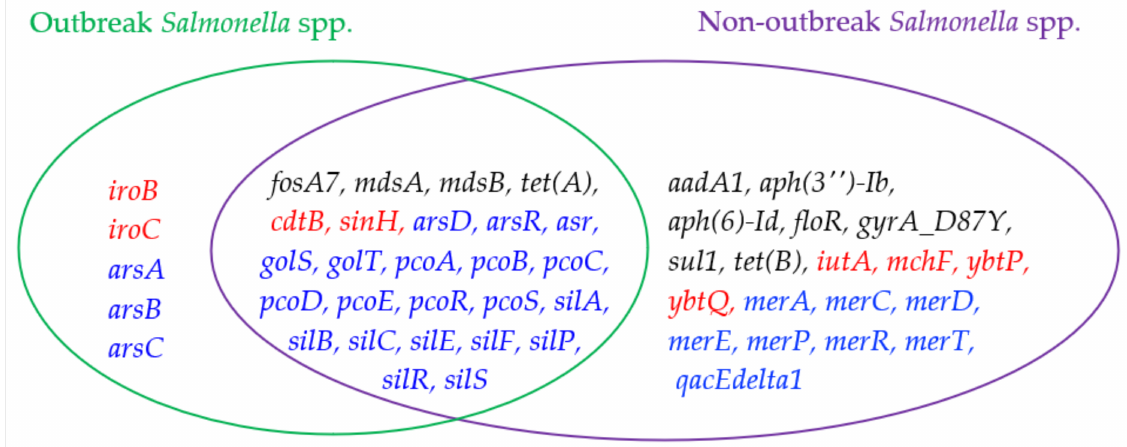
Figure 4. A comparison of outlier genes detected in outbreak Salmonella spp. and non-outbreak Salmonella